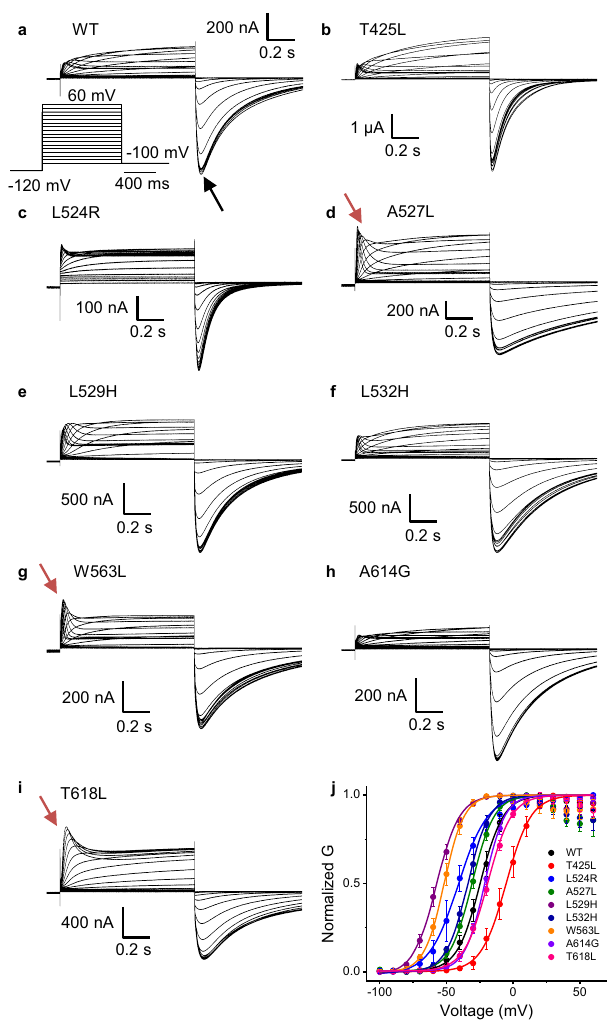
Fig.2|Familyofcurrenttracesandconductance versus voltagerelationshipfor mutants comprising the noncanonical path in hERG. a – i are the representative current tracesfor the WT,T425L, L524R,A527L,L529H,L532H, W563L,A614G, and T618L, respectively. Inset in a is the voltage protocol used and the black arrow denotes the time where the tail currents were measured at – 100mV to obtain the G-V curves. j Voltage dependence of activation (G-V curves) for the channels stu- died. The experimental data were fi tted using Eq. 6 and the best fi tted values were displayed in Table 1. The holding potential was – 100mV. Data are presented as mean±SD (WT ( n =4), T425L ( n =4), L524R ( n =6), A527L ( n =4), L529H ( n =4), L532H ( n =4), W563L ( n =4), A614G ( n =4), and T618L ( n =4), where n is the number of biologically independent cells).